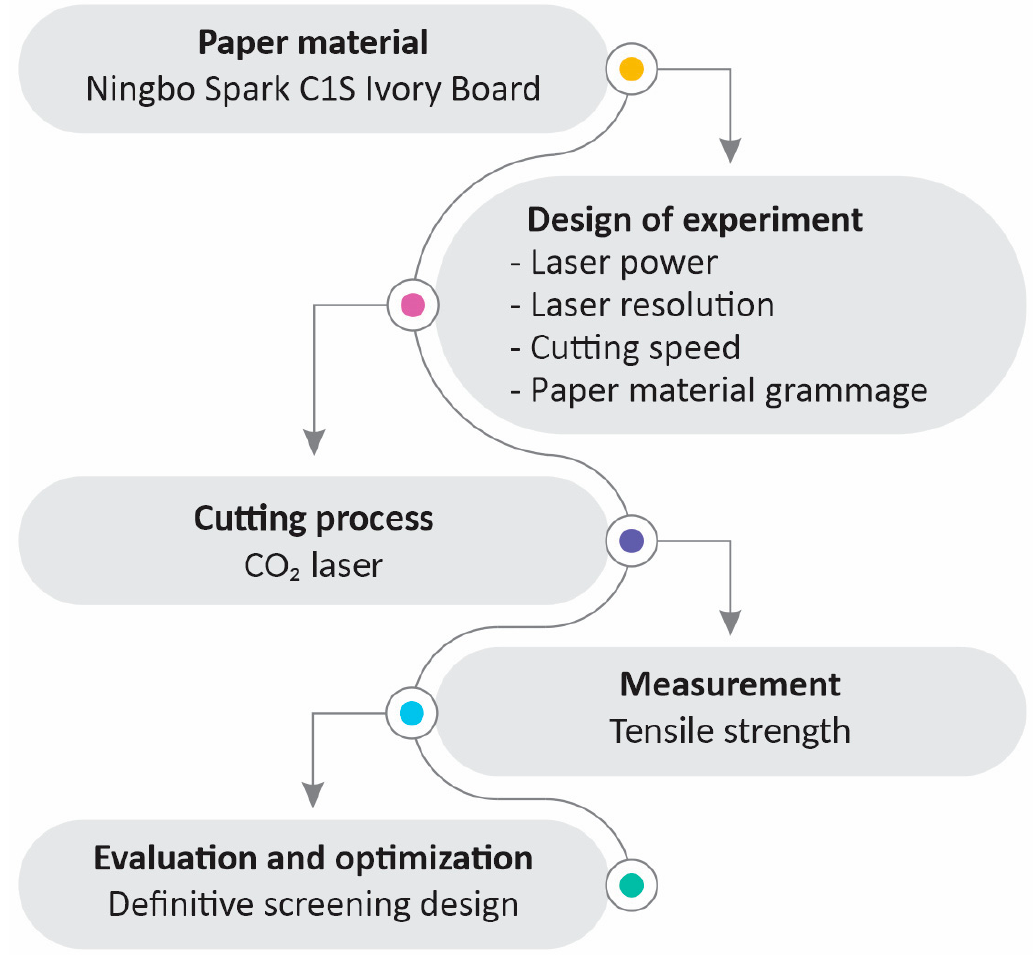
Figure 1. Research Figure 1. Research methodology.